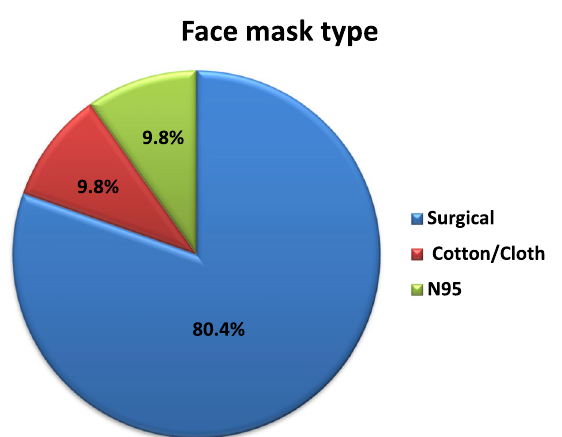
Fig. 1 Frequency of the type of face mask used by the study subjects